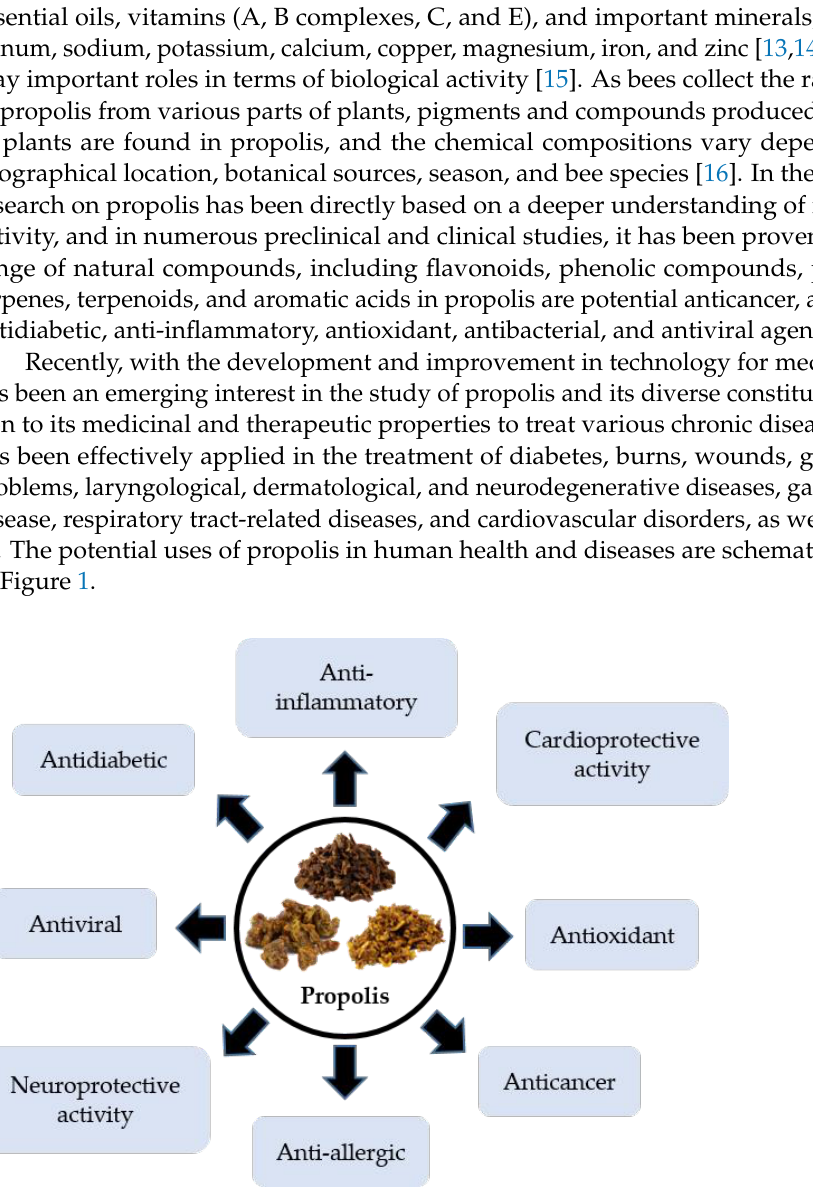
Figure 1. Biological and therapeutic properties of propolis.